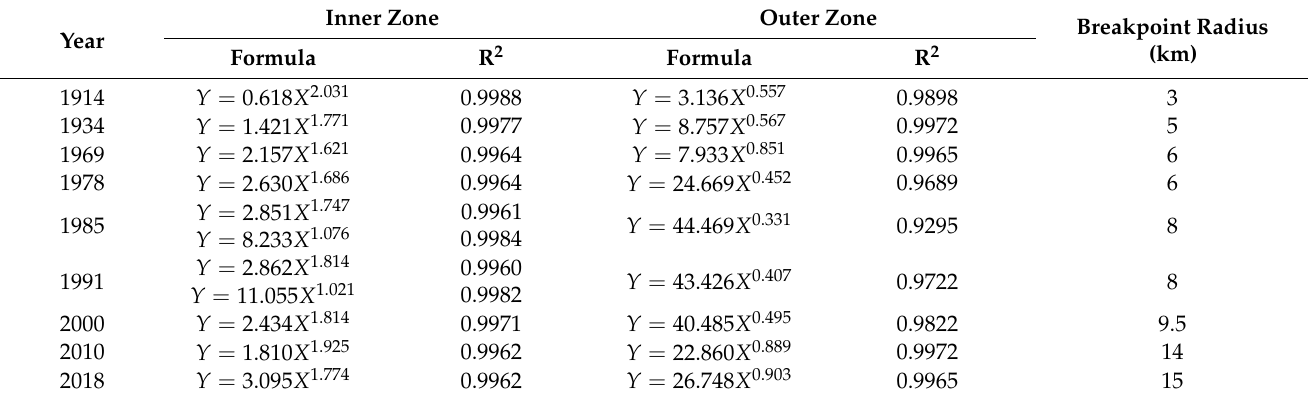
Table 4. Fitted formulas for the inner and outer zones and breakpoint radius separating the two scaling